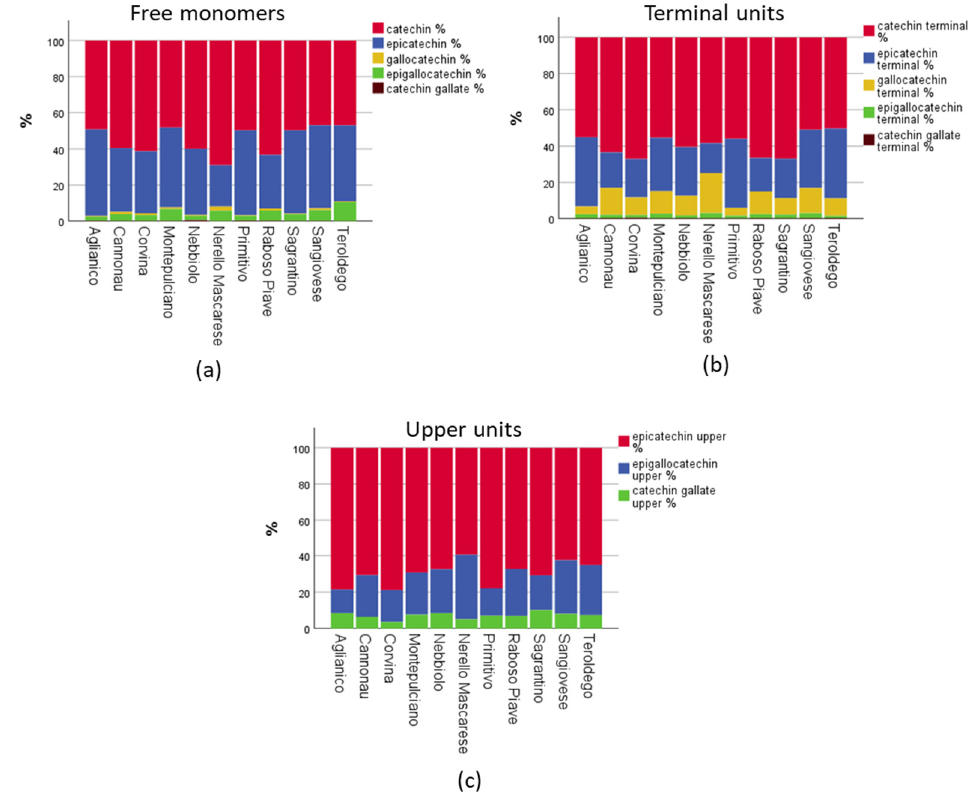
Figure 9. Relative abundance of the quantified flavan-3-os between the ( a ) free monomers, ( b ) terminal units, and ( c ) upper units.